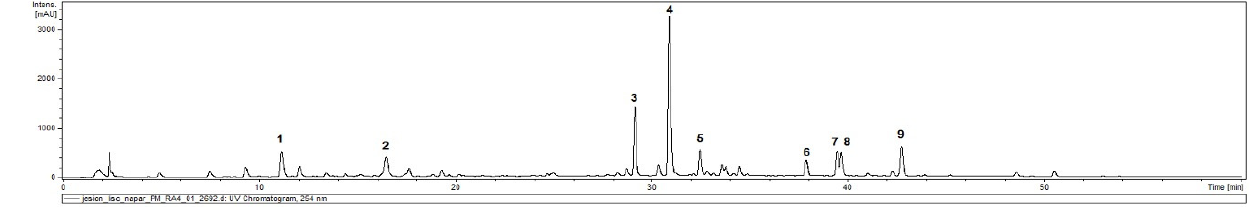
Figure 1. HPLC-DAD chromatograms of the infusion of common ash leaf sample recorded at 254 nm.